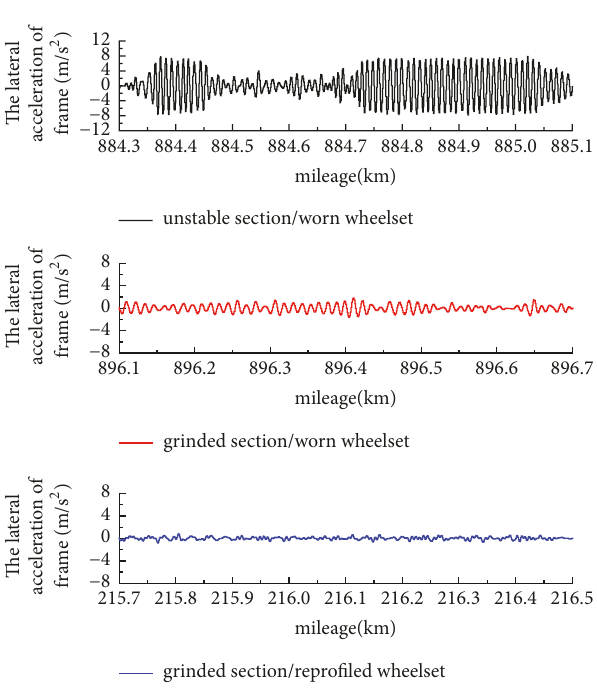
Figure 7: The lateral acceleration of bogie frame in different sec-